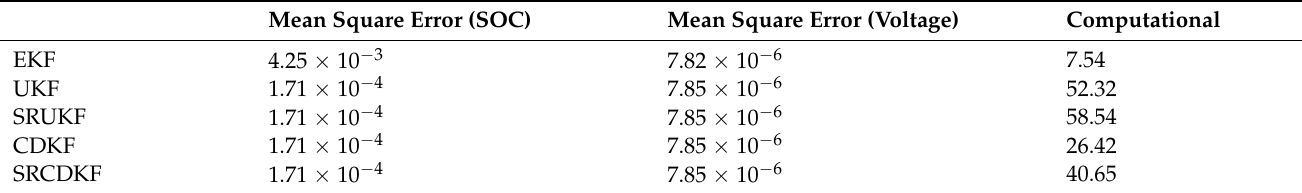
Table 5. Result comparison for model 2.